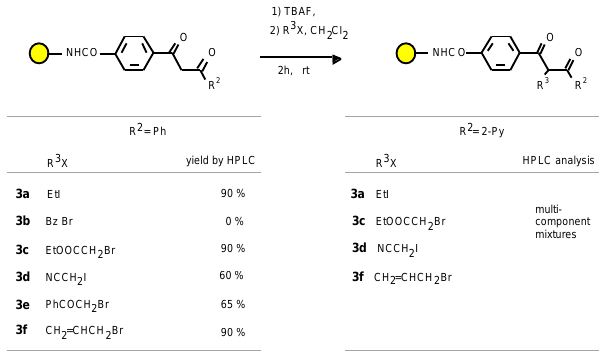
Table 3 . a -Alkylation of diketone 2a (R 1 = 4-Ph, R 2 = Ph).